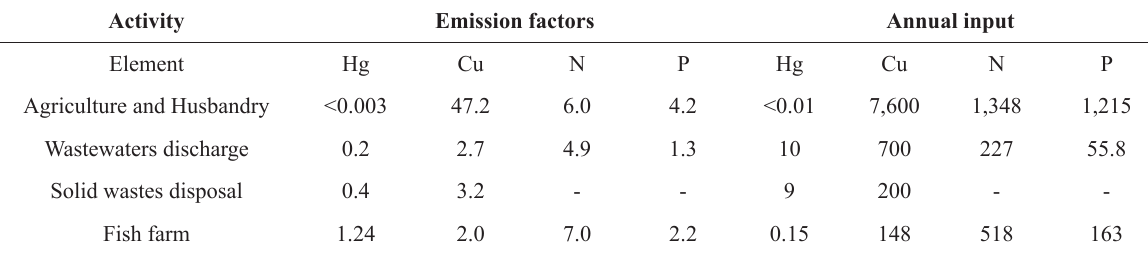
Comparison of nitrogen, phosphorus, copper and mercury emission factors (Cu, N, and P; kg.ha -1 .yr -1 ) (Hg; g.ha -1 .yr -1 ) and average total annual loads from different anthropogenic activities (Cu and Hg; kg) (N and P tons) after (Lacerda et al. 2011, Avelino 2015, Oliveira et al. 2017) occurring in the Jaguaribe River Basin and Castanhão Reservoir fish farm,